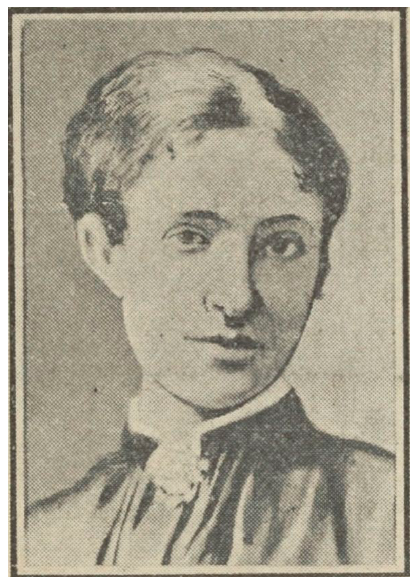
Fig. 1 Aline Valette (1850–99), reproduced from vol. 2 of the Encyclopédie socialiste, syndicale et coopérative de l’Internationale ouvrière (1912), p. 29.